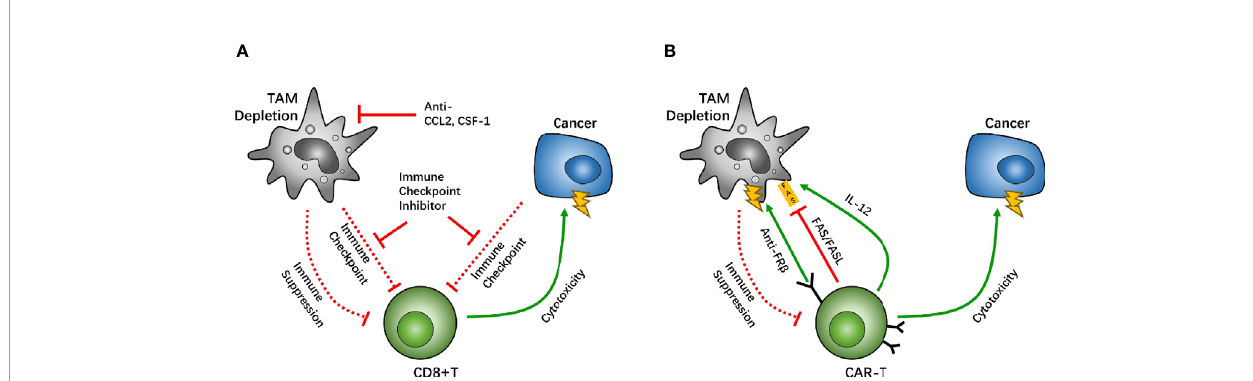
FIGURE 2 | Macrophage depletion is a potential target between tumor associated macrophages (TAMs) and CD8-positive (CD8+) T cells, which holds back the immunosuppressive function of TAMs. The CC-chemokine receptor 2 (CCR2) and colony-stimulating factor 1 receptor (CSF1R) are key factors for macrophage recruitment and migration. Studies have suggested that inhibition of TAM recruitment enhances the ef fi cacy of immune checkpoint therapy (A). Other studies have suggested that the chimeric antigen receptor T (CAR-T) cell overexpresses CAR-T cells with IL-12, causing TAM death through the FAS/FASL pathway, and anti- folate receptor b (FR b ) CAR-T cells have lethality toward TAMs (B)